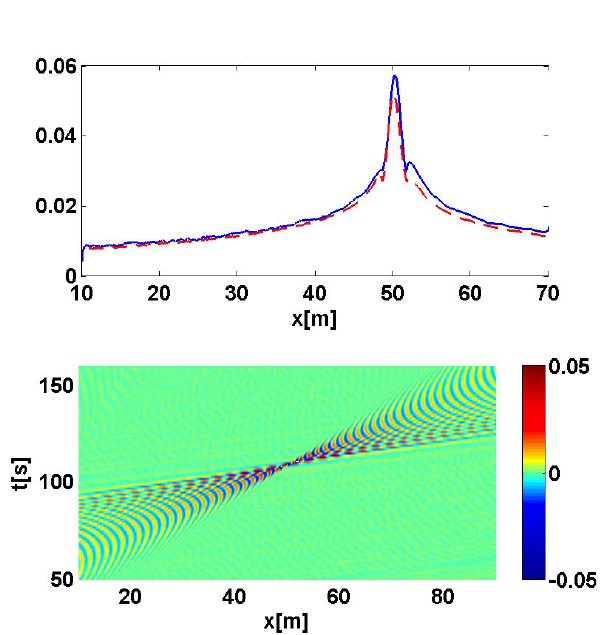
Fig. 11. Top: Maximal Temporal Amplitude of linear (dashed) and nonlinear (solid) AB simulation; Bottom: Density plot of the non- linear AB